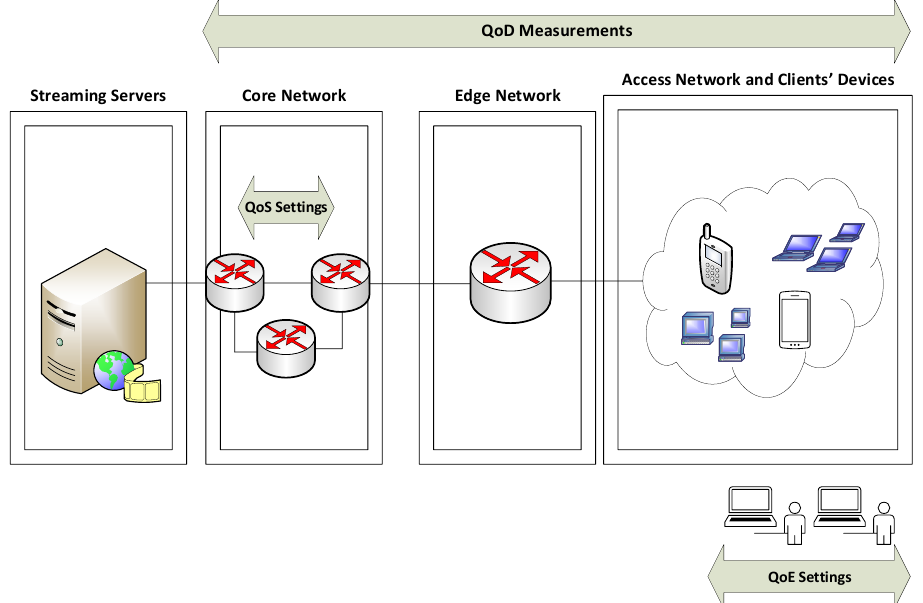
Figure 1. QoD measurements capture the end-to-end performance of the data delivery process from the core network to access networks and client devices. QoS settings are applied at the core IP routers to provide differentiated handling and capacity allocation to certain network traffic flows. QoE evaluations are conducted on a subjective basis. The mean opinion score (MOS) or perceptual evaluation of speech quality (PESQ), for example, is then calculated for these